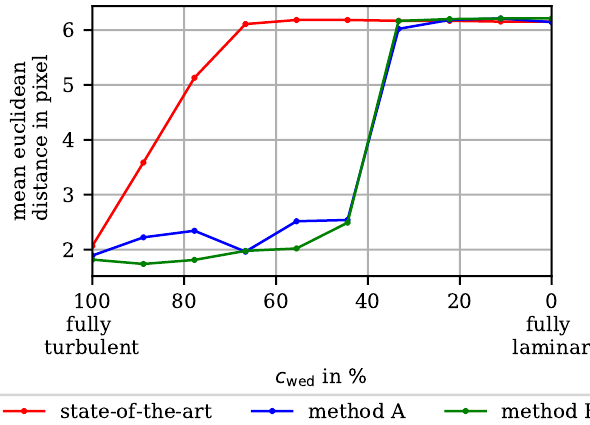
Figure 9. Mean euclidean distance between the true transition line and the evaluated transition lines of the state-of-the-art image processing (red), method A (blue), and method B (green) over the relative contrast of the turbulence wedge from the maximum (100% = fully turbulent wedge) to the minimum (0% = fully laminar wedge). The introduced image processing methods A and B are able to cope with a much lower contrast (~40%) compared to the state-of-the-art method (~90%) at which the evaluation is still able to detect the turbulence wedge. This contrast limit for the detection can be noted by the sudden increase of the mean euclidean distance for lower c wed